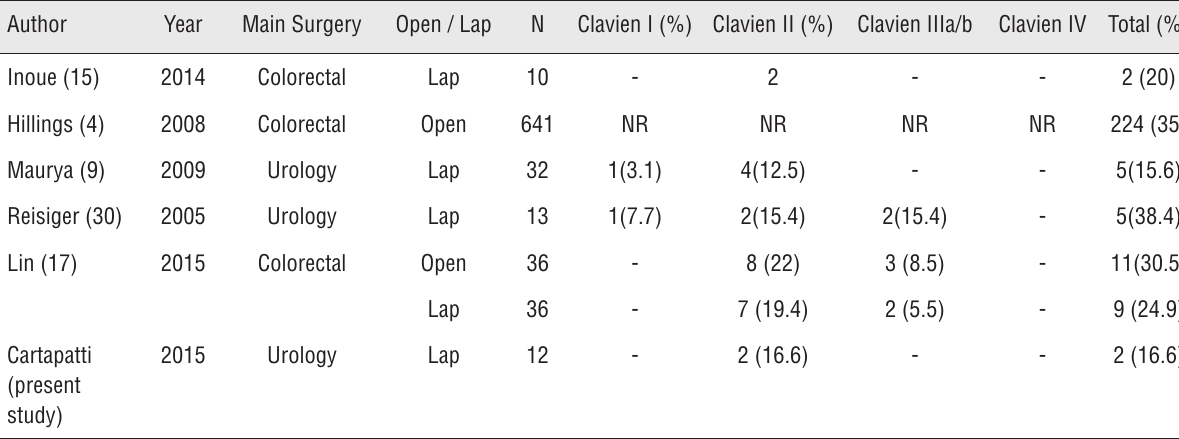
Table 3 - complications described in